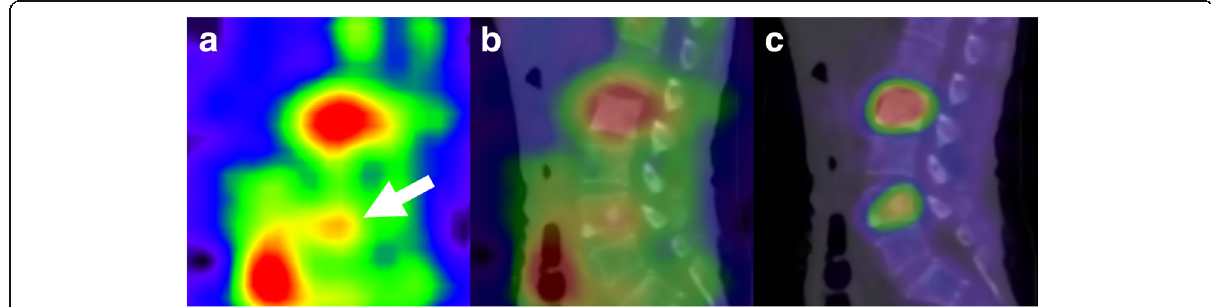
Fig. 8 Coexistence of bowel uptake and bone metastasis in the lumbar spine revealed with Ra-223 SPECT (patient no. 6). SPECT ( a ) and SPECT/CT fused images ( b ) show that uptake in a bone metastasis at the fourth lumbar vertebra (arrow) is weak compared to adjacent bowel uptake. The corresponding Tc-99m HMDP SPECT/CT image ( c ) shows no bowel uptake. HMDP hydroxymethylene